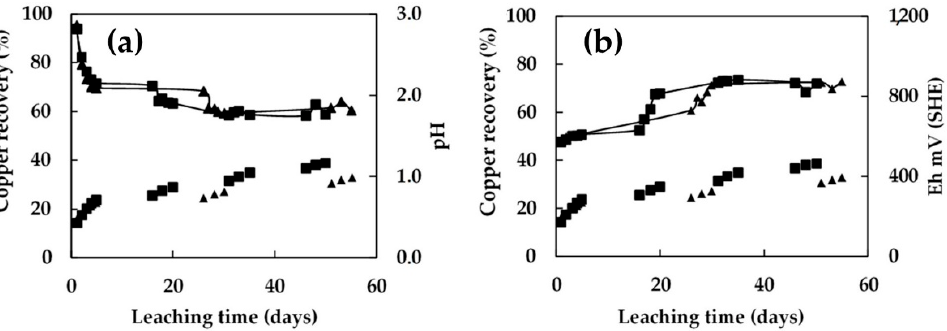
Figure 7. Effect of the irrigation cycle on the rate of column leaching of the chalcopyrite ore in a solution of 2 g/L acid, 0.5 g/L copper (II), and 15x10 7 cells/mL at ambient temperature, with an intermittent irrigation cycle. ■ pH 1.8 and a 5/10-day irrigation cycle; ▲ pH 1.8 and a 5/20-day irrigation cycle. ( a ) Variation in pH (dashed line); ( b ) variation in Eh (dashed line).